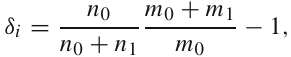
Table 3 The efficiency corrections for different conditions. The condition numbers from Sect. 3 are used